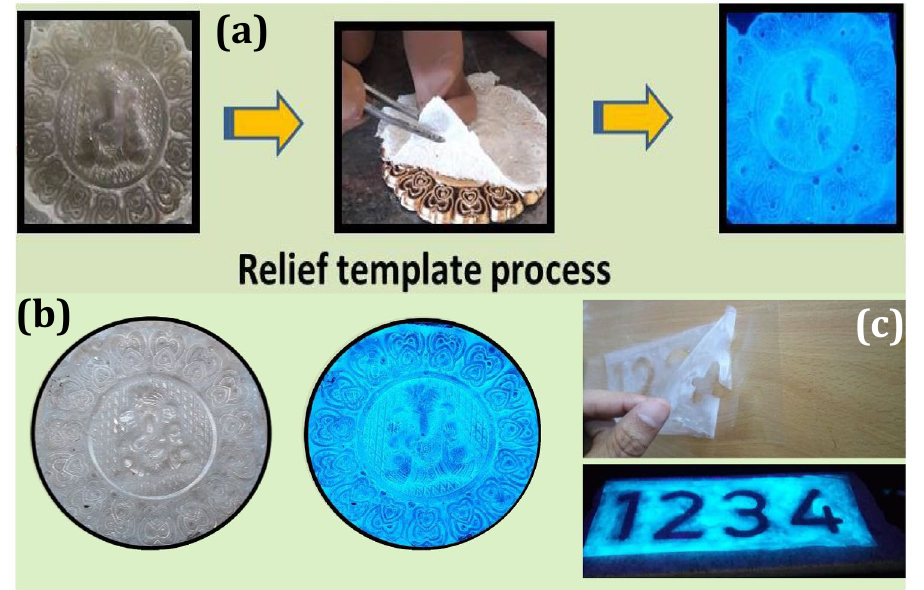
Figure 12. ( a ) Schematic representation of simple ink-free relief template method; ( b ) Photographed images of developed “lord Ganesha” film by relief template method upon visible and UV 365 nm irradiation; ( c ) xylographic images developed by following ink-free intaglio printing method with prepared PVA/FDIP under normal and UV 365 nm